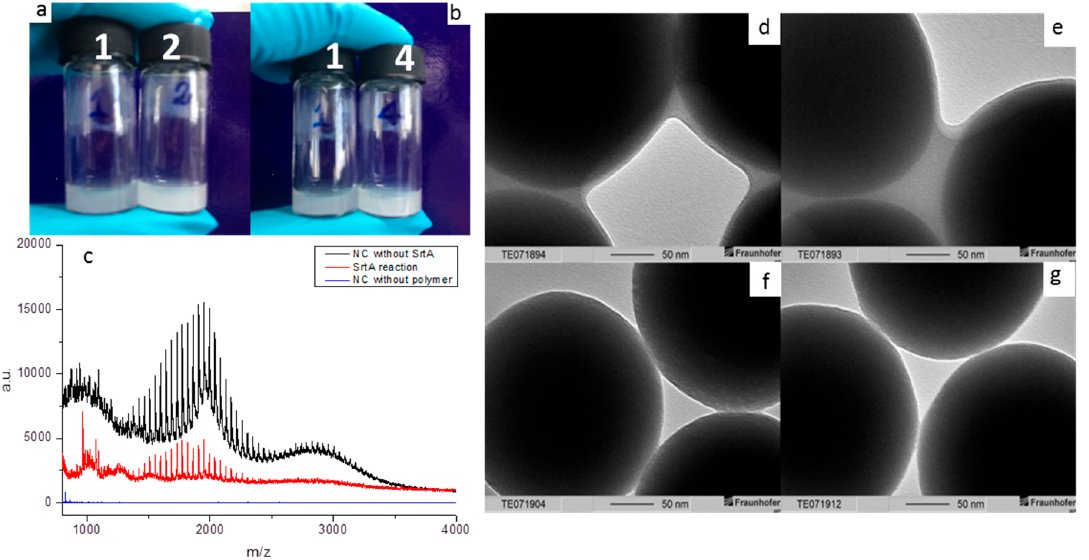
Figure 1. ( a , b ) Dispersability comparison between 1: Nanoparticle (NP)–polymer after SrtA reaction; 2: mixture of functionalized NPs and SrtA without polymer; 4: mixture of functionalized NPs and poly(ethylene glycol) (PEG) without SrtA; ( c ) MALDI-ToF mass spectra of NP–polymer sample after SrtA reaction showing only unmodified free polymer (red), negative control solution without SrtA showing both unmodified free polymer as well as peptide–polymer (black), and negative control with SrtA but without peptide–polymer (blue); ( d – g ) Transmission electron microscopy (TEM) images of NP–polymer hybrid particles after SrtA reaction ( d , e ), negative control without polymer ( f ), and negative control without SrtA ( g ).